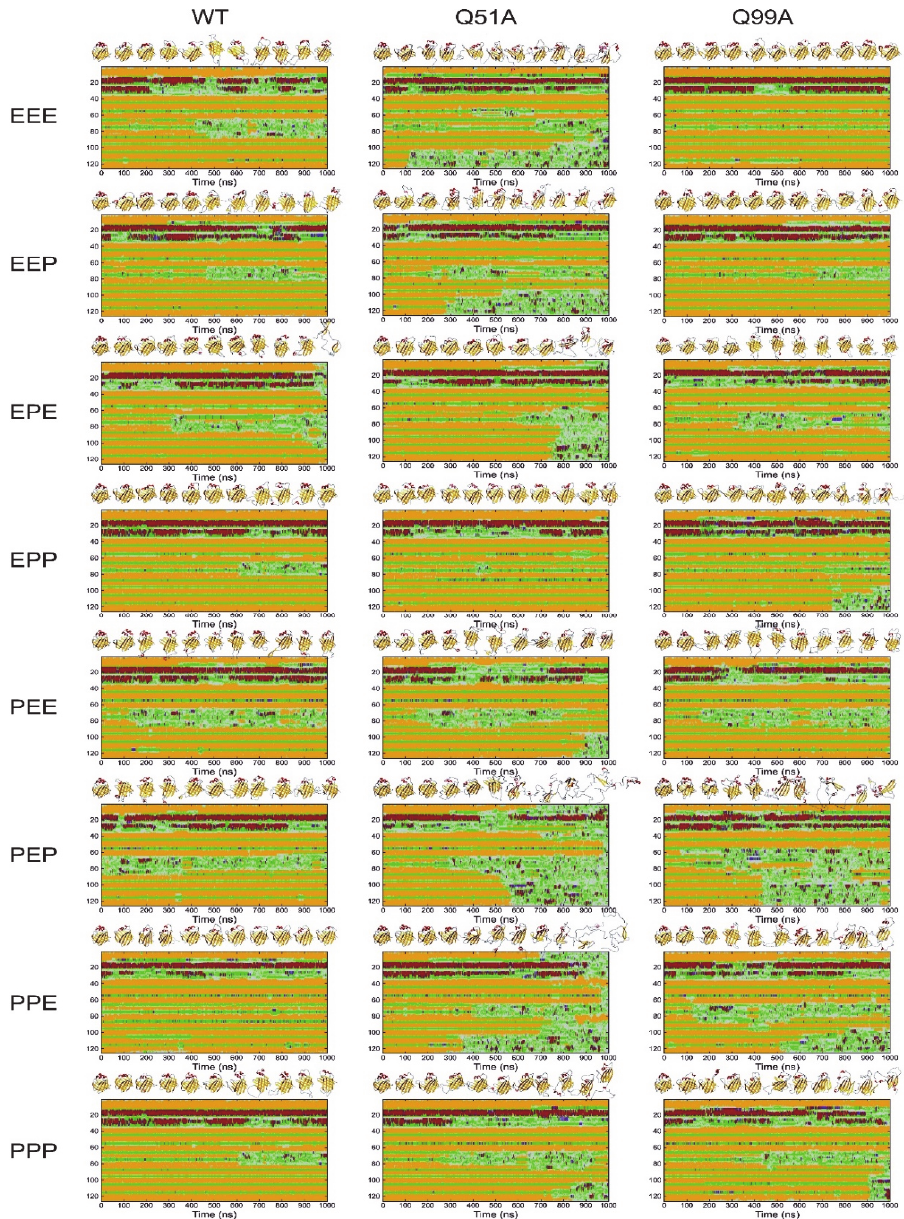
Figure 10. Comparison of the stability and flexibility of WT, Q51A, and Q99A apo hI ‐ BABPs by 1 μ s MD simulations at 373 K in all possible combination of histidine protonated states (E: uncharged, P: cationic, e.g., PPP indicates that His residues H52, H57, and H98, are all protonated). Secondary structure composition is presented along the sequence as a function of time (color coding: red: α ‐ helix; purple: 3 10 ‐ helix, yellow: β ‐ strand, green: turn, gray: irregular). 3D structures corresponding to every 100 ns are presented at the top of the panels.